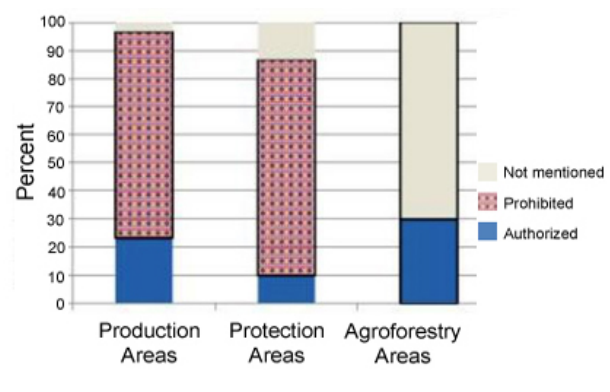
Fig. 2 . Regulation of agriculture in 30 forest management plans.